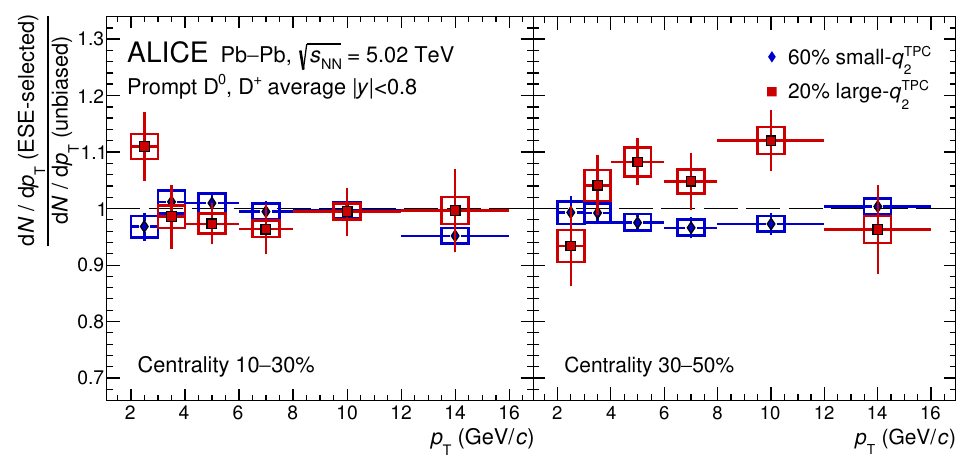
Figure 11 . Average of the ratio of D 0 and D + yields measured as a function of p T in the ESE- selected samples to those in the unbiased sample, in Pb-Pb collisions at 10{30% (left panel) and 30{50% (right panel) centrality classes. Vertical error bars represent the statistical uncertainty, empty boxes the total systematic